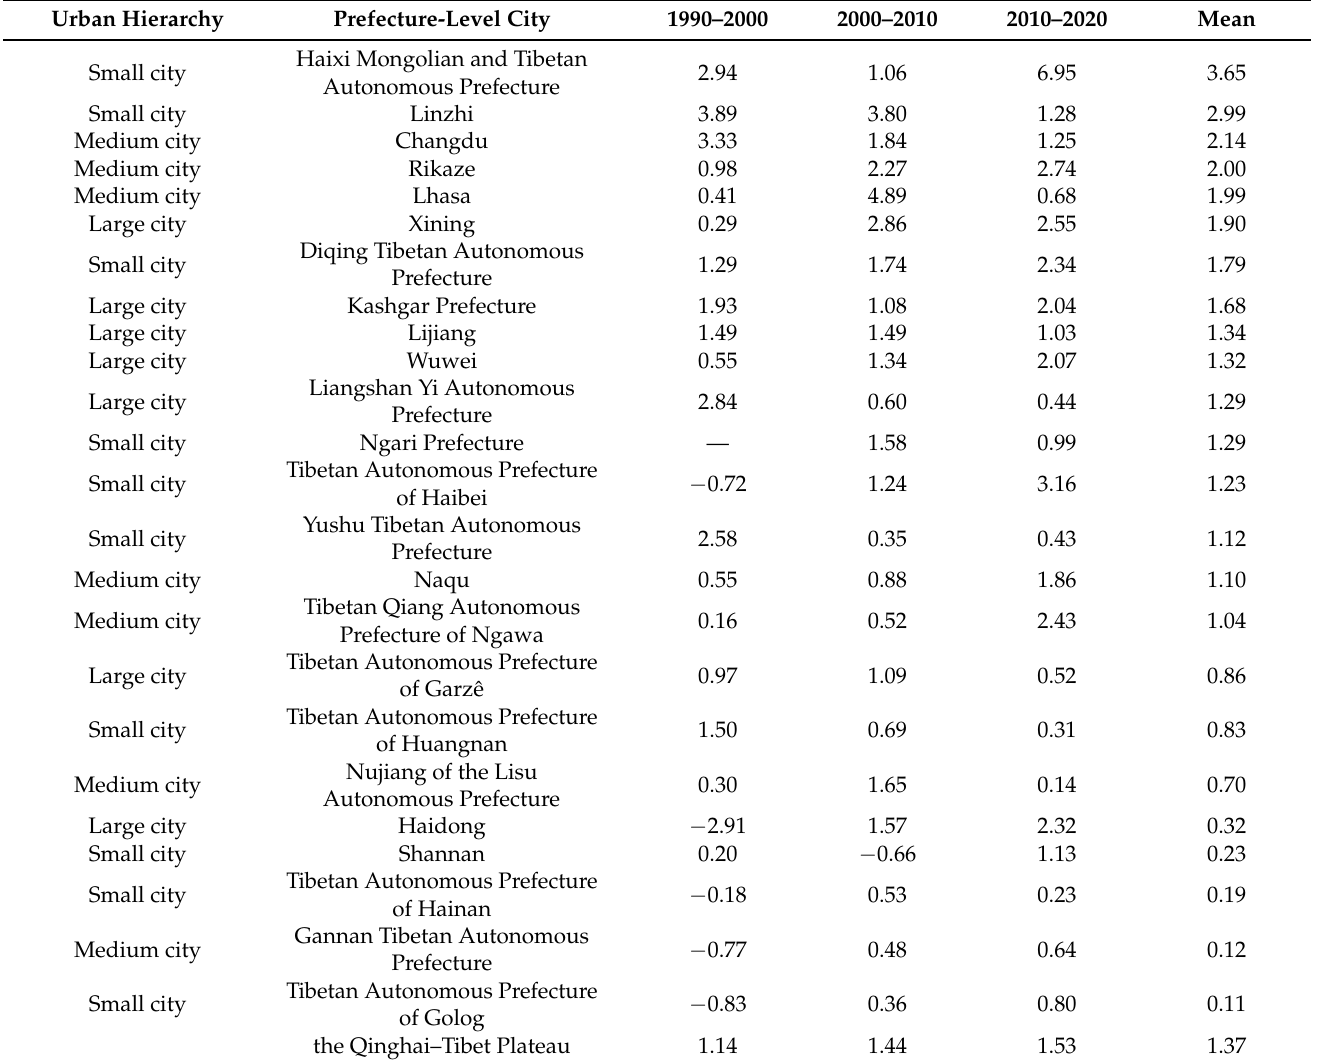
Table 2. Land use efficiency of urban areas in the Qinghai–Tibet